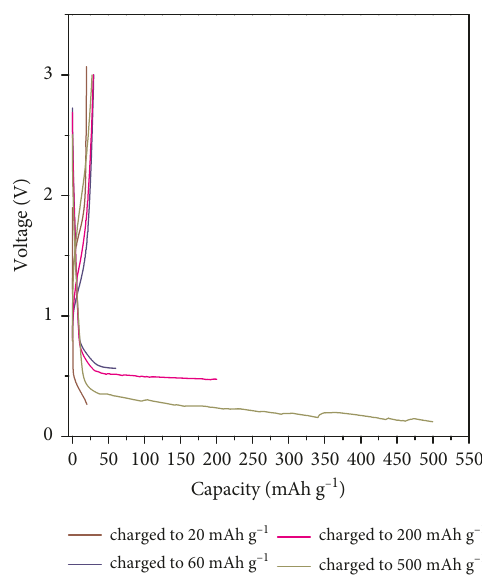
1 at each cycle. g · −